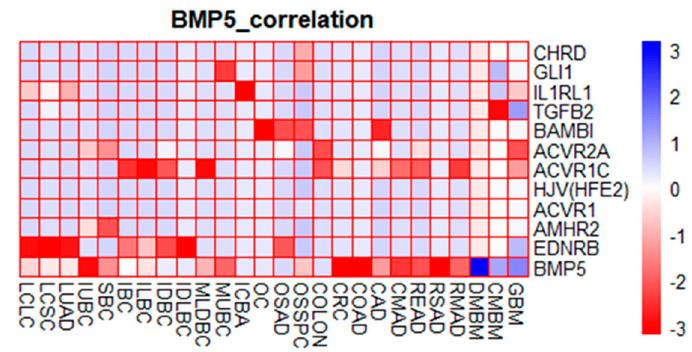
Figure 7. A heatmap visualizing co-expression profile of BMP5 in breast, colorectal, lung, bladder, ovarian carcinoma and blastoma. BMP5 is co-expressed with the indicated genes across 3 lung, 7 breast, 8 colorectal, 3 blastoma, 2 bladder, and 1 ovarian cancer sample types. Linear branches on the left and top are clustering tree grouping similar expression pattern of BMP5 gene in di ff erent cancer types. The color scale indicates the expression value (Dark blue indicate higher expression, red indicates lower gene expression). The heat map was generated with custom scripts based on pheatmap function as available in the ‘gplots’ Bioconductor package of